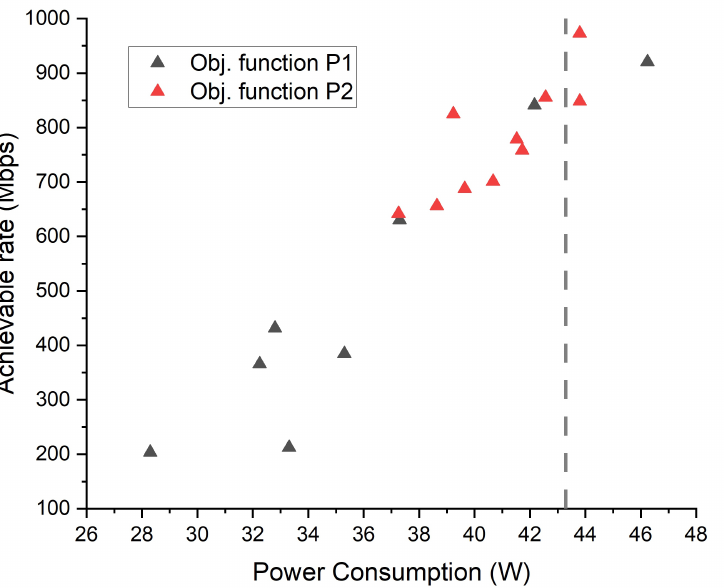
Figure 4. Achievable rate and power consumption with β = [ 0.1,0.2, · · · ,1 ] for different objective functions. The vertical dashed line ( x = 43.3) represents the average power generated by the